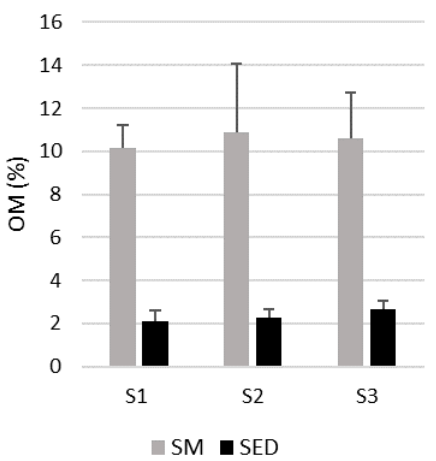
Figure 5. Average OM concentrations in suspended matter (SM) and sediment samples (SED) collected at stations S1 to S3 in Kaštela Bay (Adriatic Sea, Croatia) from April 2015 to March 2016. 3.2. BPA